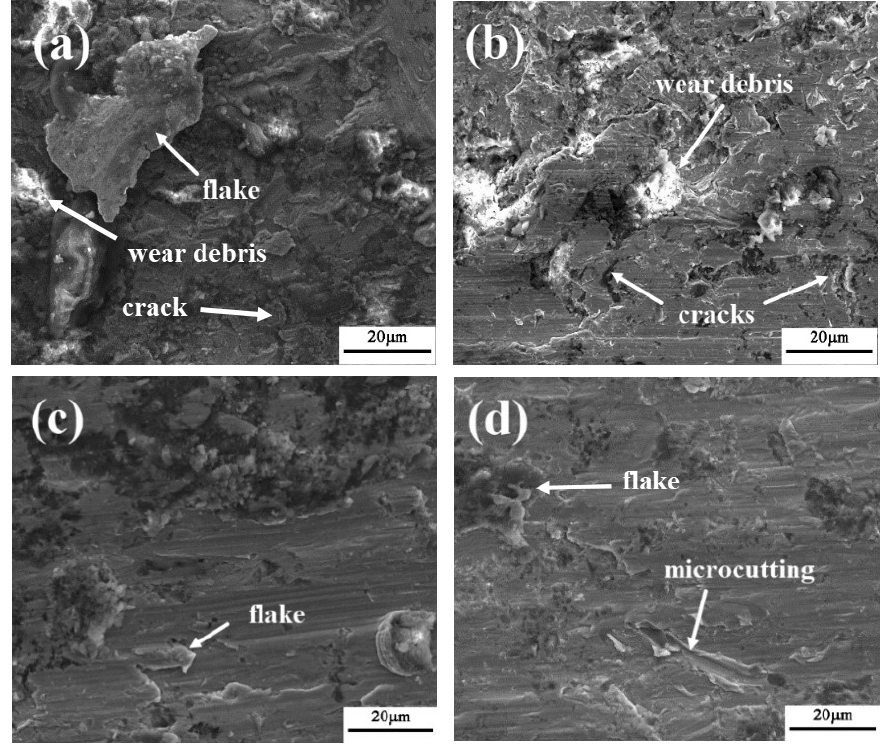
Figure 9. Worn surface of different samples: ( a ) A200; ( b ) A400; ( c ) B200; and ( d ) B400. The curves of mass loss during six wear cycles and total mass loss verses wear time are presented in Figure 10. The mass loss increases with the isothermal holding time and